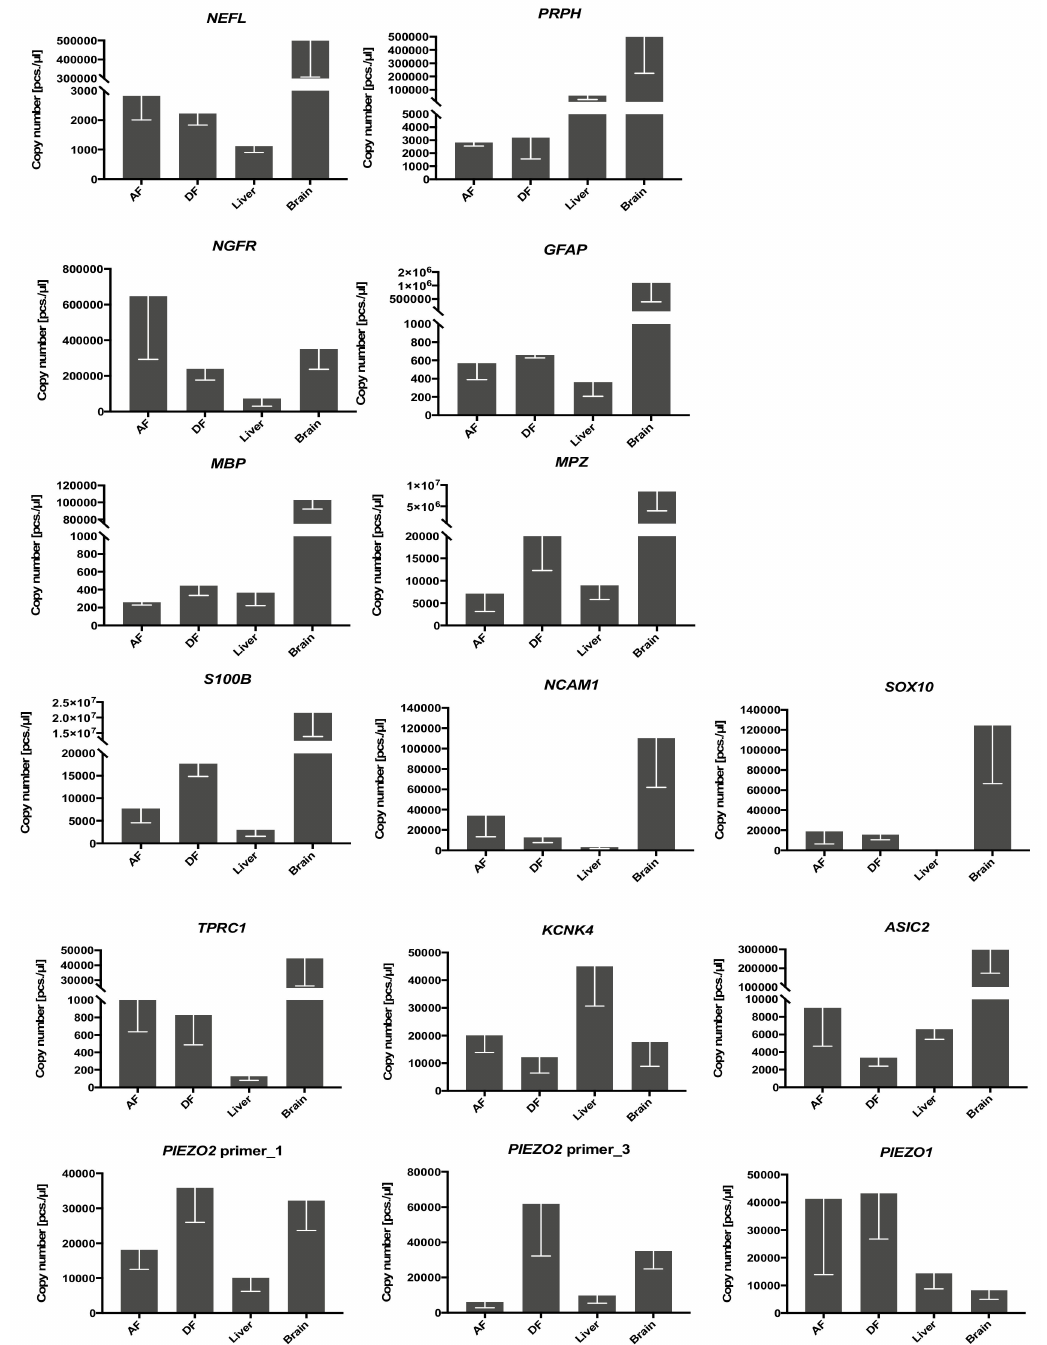
Figure A2. Expression levels of Set 1 and Set 2 marker genes across tissues in C. maraena . The expression levels are given as absolute copy numbers (per 1 µ g RNA) normalized against three reference genes. Statistically significant deviations are indicated only between AF and the other tissues. Expression values determined in brain were excluded from the statistical evaluation. Significance levels are indicated by * p ≤ 0.05, ** p ≤ 0.01, *** p ≤ 0.001. Error bars indicate the